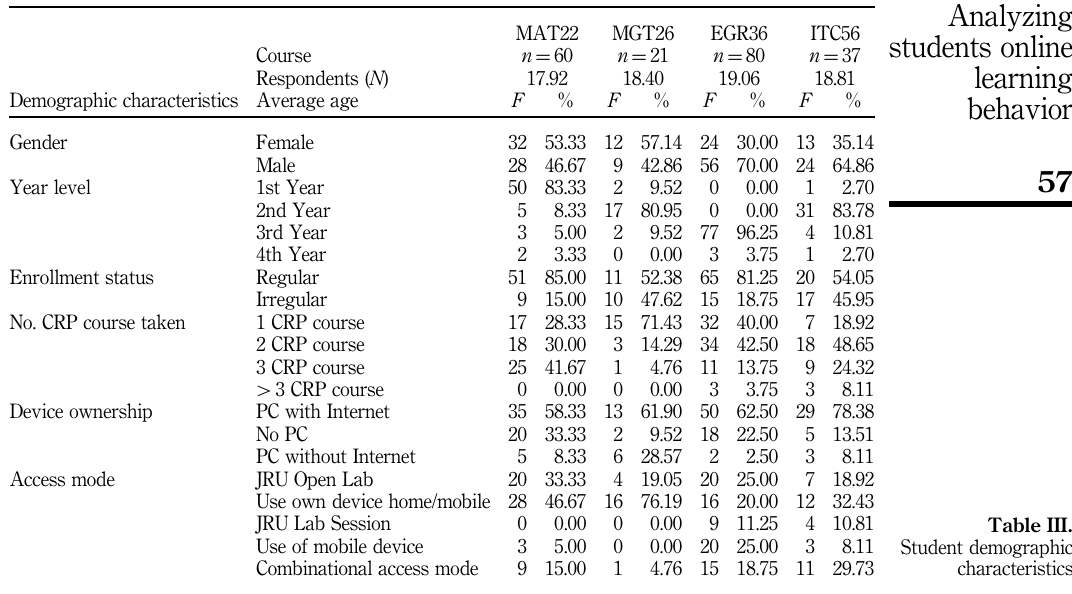
Table III. Student demographic